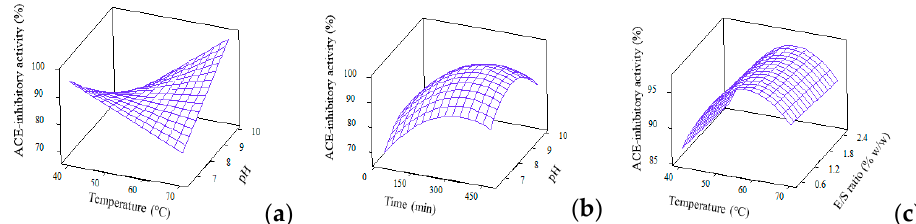
Figure 3. 3D surface plots for ACE-inhibitory activity (%) as affected by ( a ) Temperature and pH; ( b ) Time